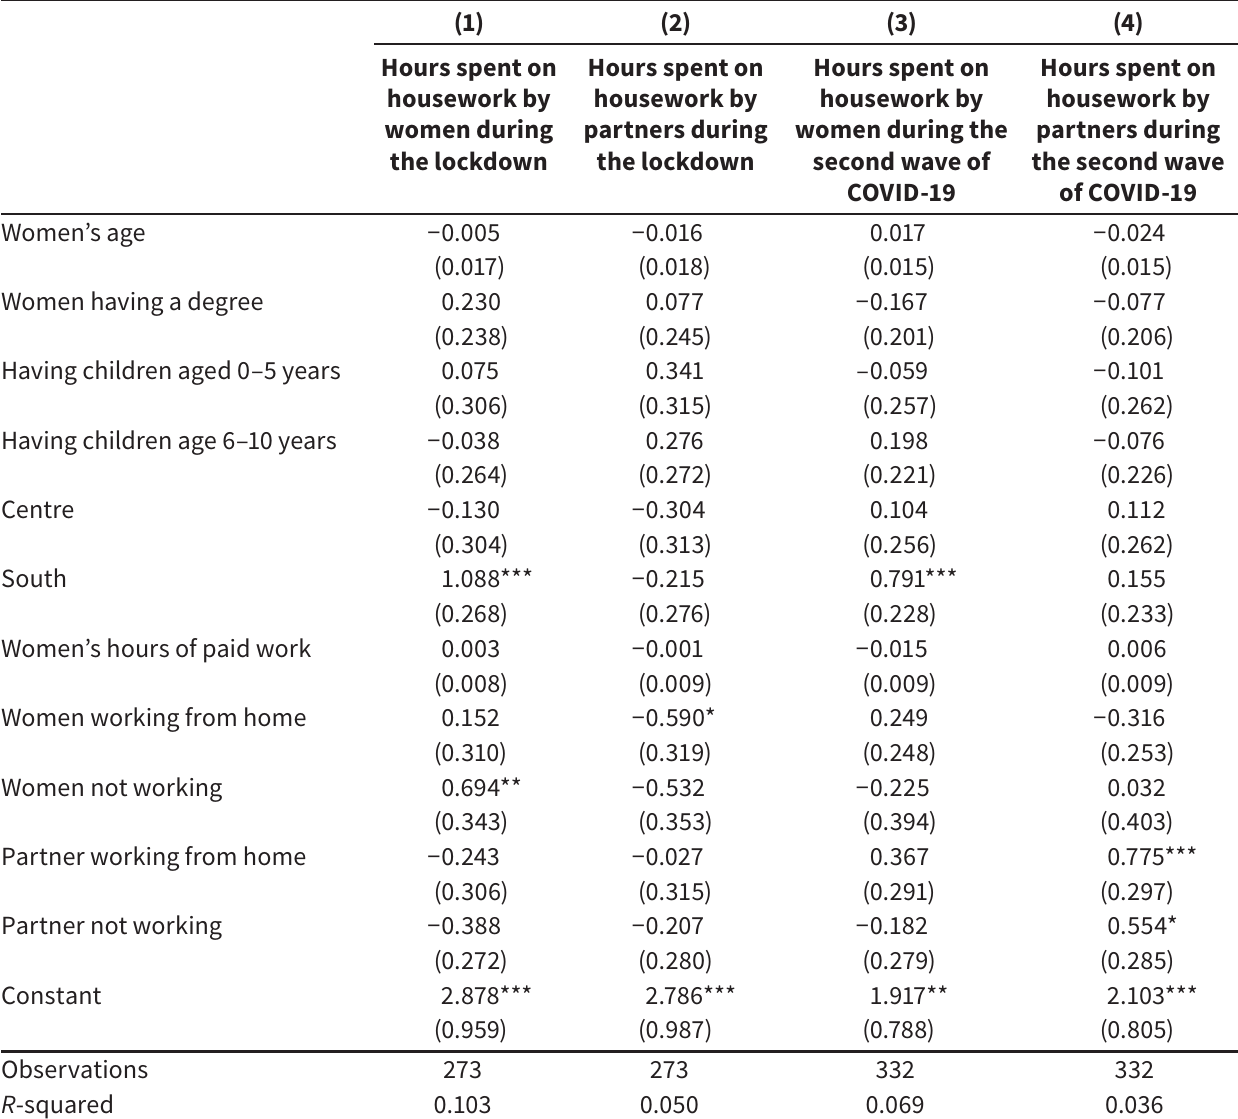
Multivariate regression model of hours spent on housework by women and their partners during the first and second waves of COVID-19 (sample restricted to women with